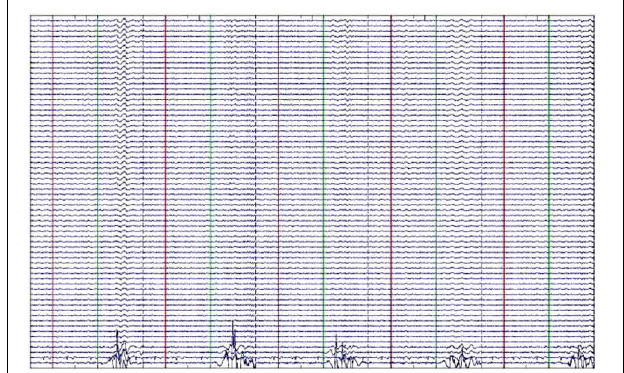
FIGURE 2 | Stereotypic muscle activity from perilabial EMG electrodes. Example of filtered and epoched EEG data from the WorP condition showing stereotypical EMG activity during speech